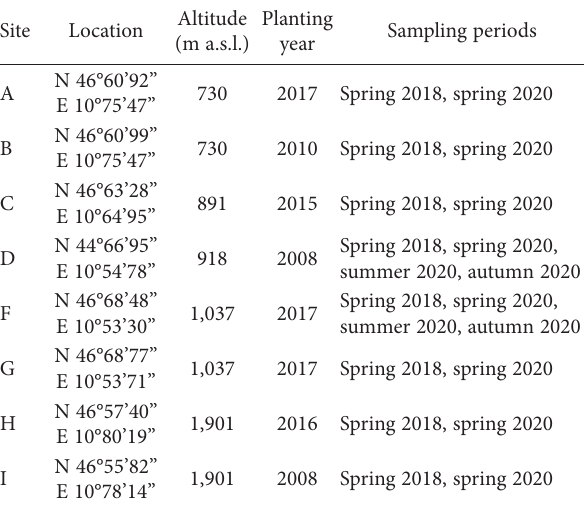
Table 1. Main sampling site parameters and sampling periods at each site, for virus assessments in South Tyrol cherry orchards. Site altitudes indicated (meters above sea level; m